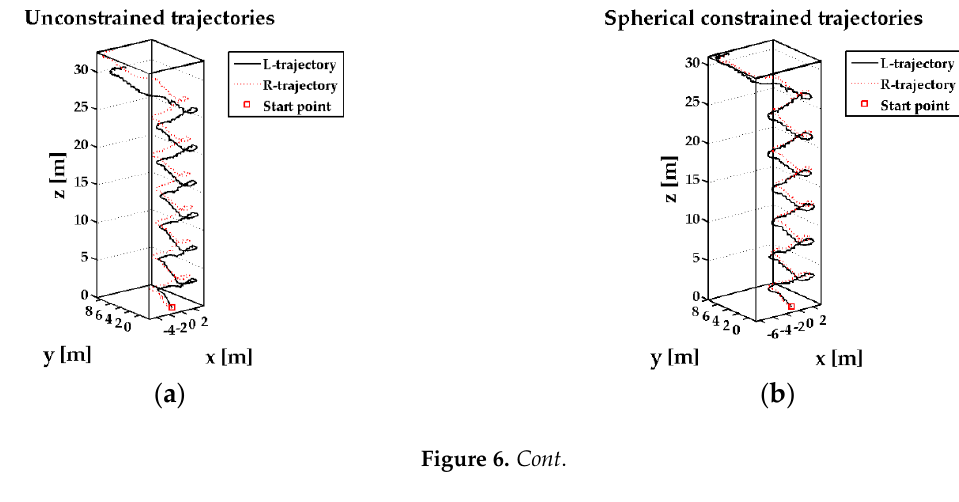
Table 2. RMSE deduction by using the ellipsoidal constraint method for a closed path test.